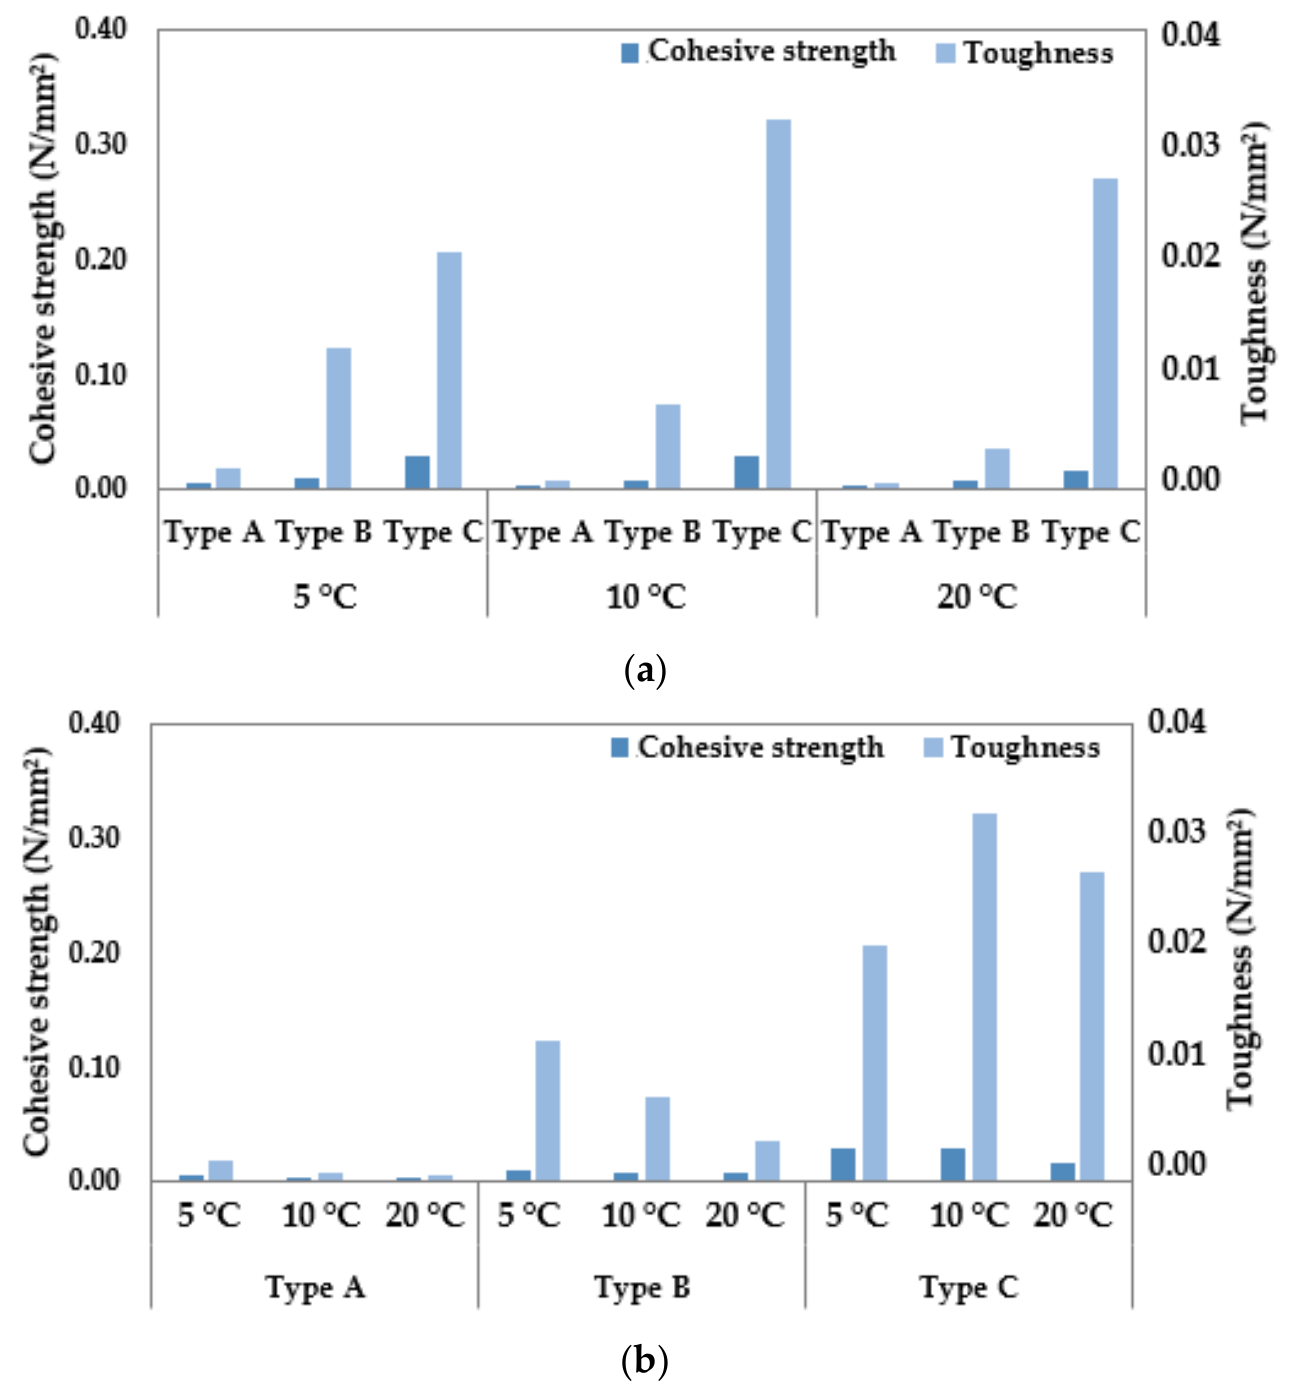
Figure 9. Cohesive strength and toughness comparison of viscosity types based on temperature condition (10 mm thickness); ( a ) toughness and cohesion strength comparison based on viscosity type, ( b ) toughness and cohesion strength comparison based on temperature condition.